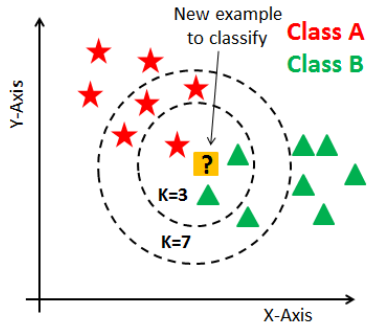
Figure 2. Representation of KNN algorithm [12].